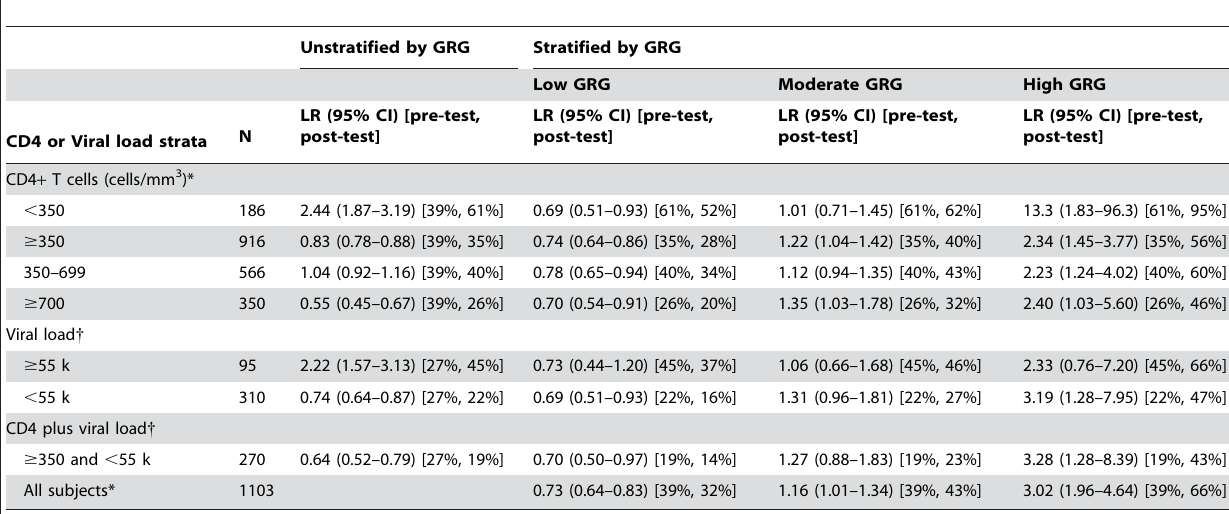
Table 1. The likelihood ratio (LR) and pre- and post-test probability of developing AIDS according to the laboratory markers and CCL3L1-CCR5